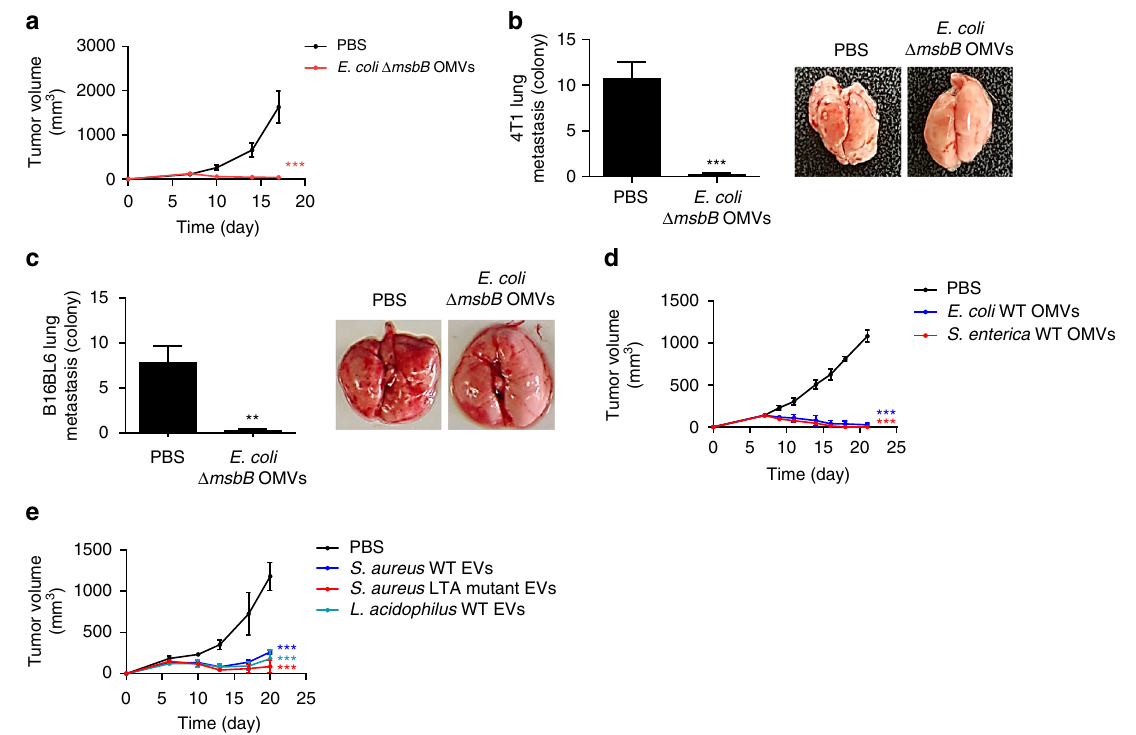
Fig. 2 Systemic administration of bacterial extracellular vesicles induces effective antitumor responses in multiple tumors. a Tumor volume of mice measured after the subcutaneous injection of MC38 murine adenocarcinoma (total n = 14 mice per group, two independent experiments). E. coli Δ msbB OMVs (5 μ g in total protein amount) were injected intravenously four times from day 7 with 3 days intervals. b , c To induce spontaneous lung metastasis, highly metastatic 4T1 murine carcinoma cells and B16BL6 melanoma cells were subcutaneously injected to the right fl ank of the mice (total n = 12 mice per group, two independent experiments). PBS or E. coli Δ msbB OMVs (5 μ g in total protein amount) were intravenously treated for four times with 3 days intervals from day 7. At day 22, mice were killed and the number of colonies spontaneously metastasized in the lungs for 4T1 b and B16BL6 c tumors were counted. d , e Tumor volume of mice bearing CT26 tumor of mice intravenously injected with four doses of 5 μ g of Gram-negative E. coli W3110 wild type- and Salmonella enterica wild type - derived OMVs. d Gram-positive bacteria Staphylococcus aureus wild type- and lipoteichoic acid (LTA) mutant-derived extracellular vesicles (EVs), and Lactobacillus acidophilus wild type-derived extracellular vesicles (EVs), e ( n = 5 mice per group). Data are presented as the mean ± SD from a representative experiments. * P < 0.01 and **P < 0.001, respectively, analysed by unpaired Student ’ s t -test b , c or two-way ANOVA a , d , e . Bonferroni post test was applied to compare each treated group with PBS group d ,